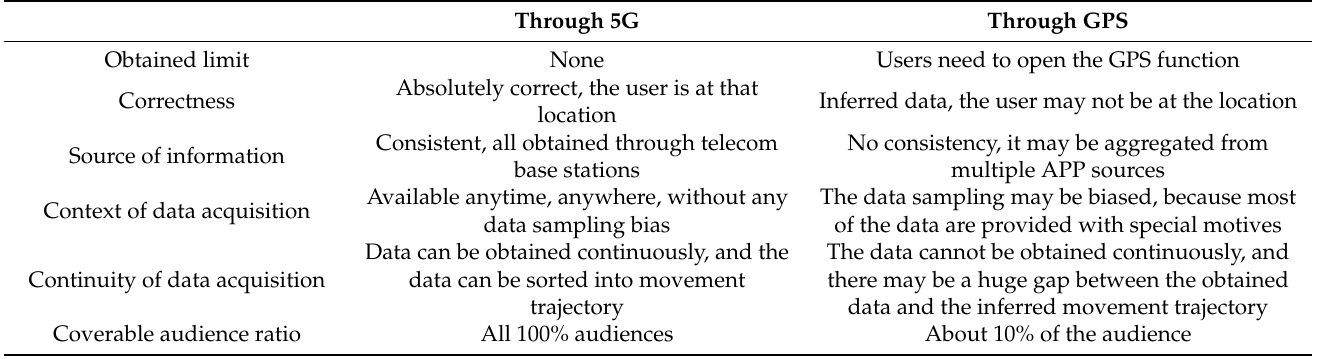
Table 15. Experimental background condition